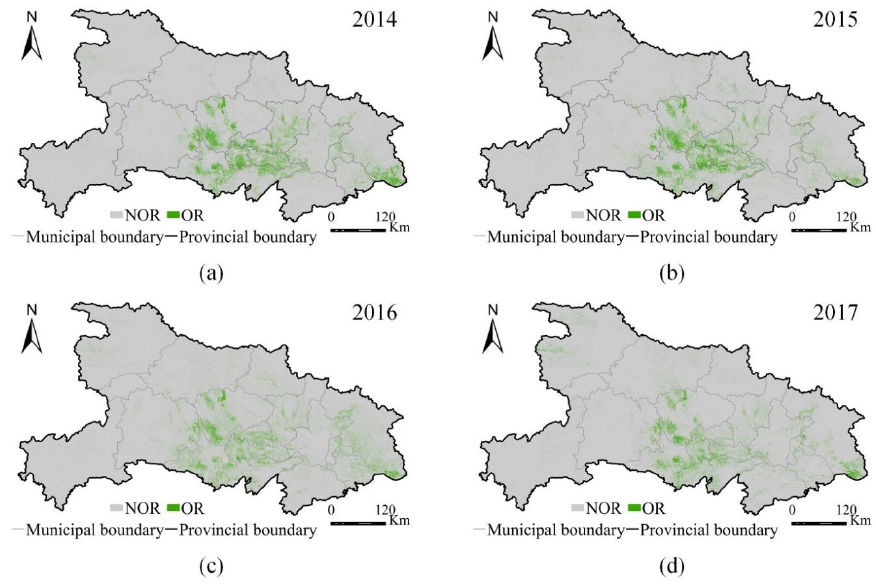
Figure 11. The CSRA-derived oilseed rape planting maps of Hubei Province in ( a ) 2014; ( b ) 2015; ( c ) 2016; and ( d ) 2017.